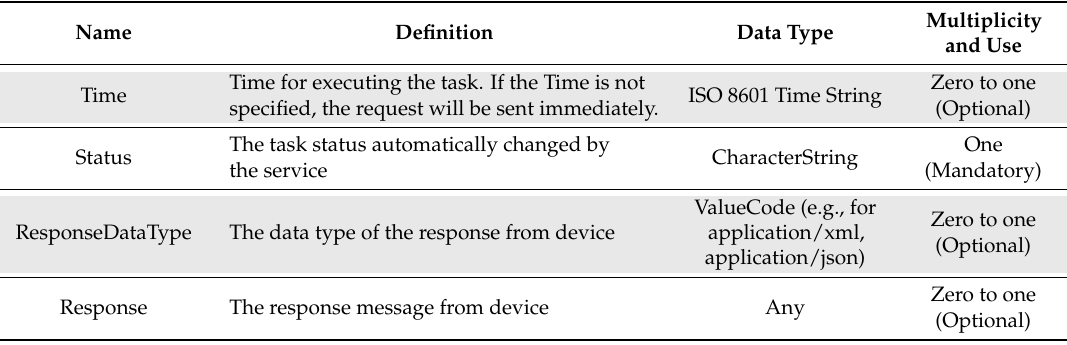
Table 10. Properties of the Task .